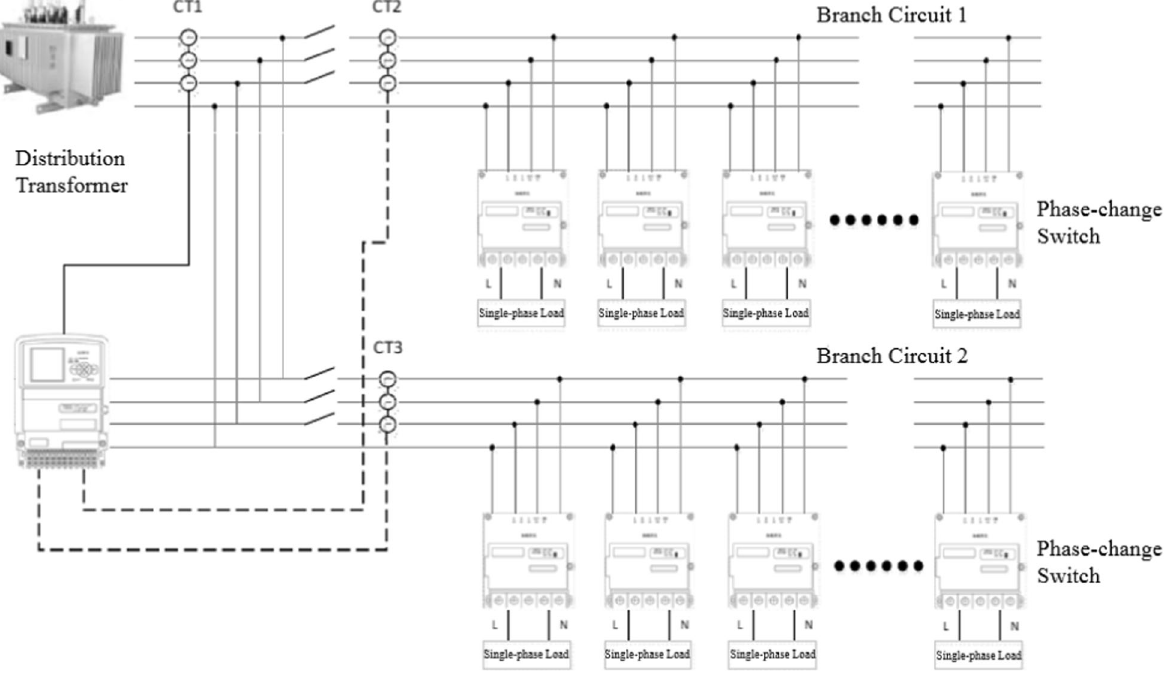
Fig. 2 Operating principle of PSD